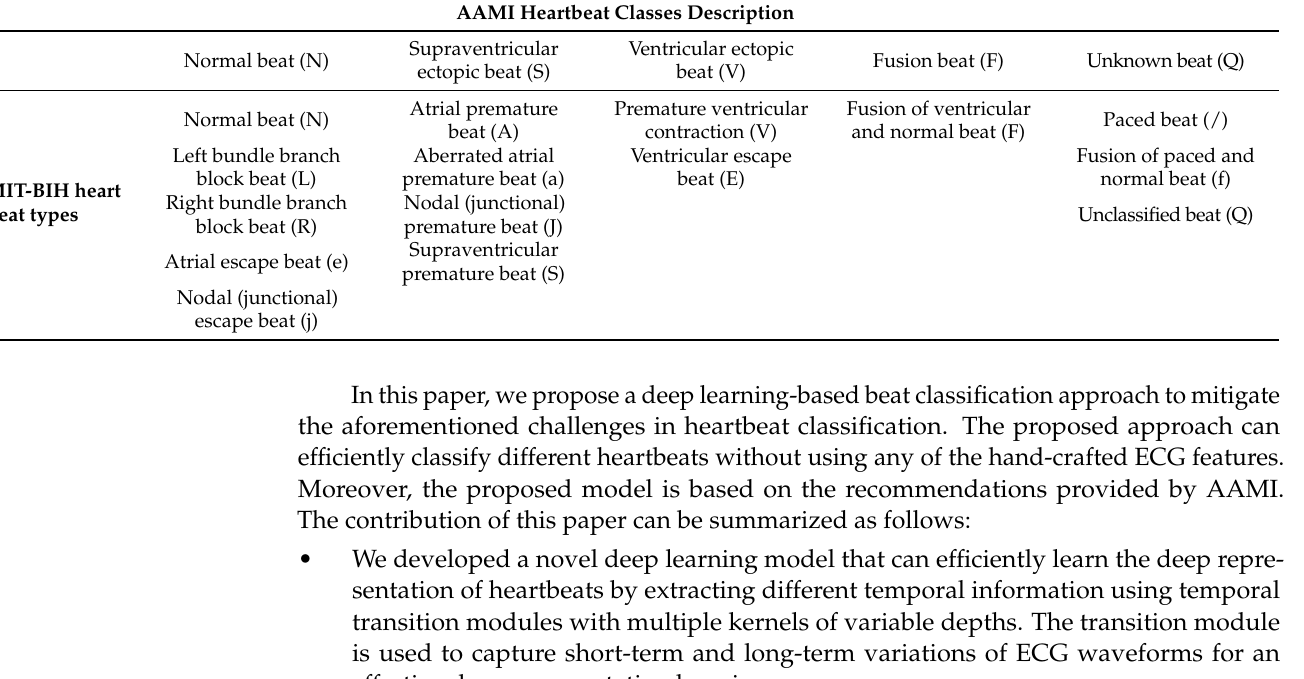
Table 1. Mapping of MIT-BIH arrhythmia database beat types to AAMI beat classes. AAMI Heartbeat Classes